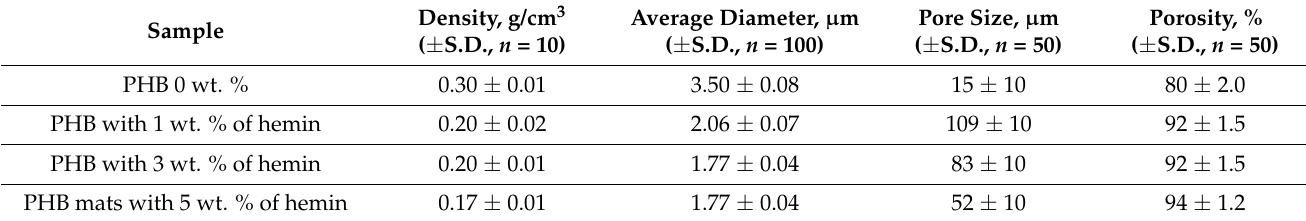
Table 1. Average values of the characteristics of the nonwoven materials based on PHB with different content of hemin. Density, g/cm 3 Sample ( ± S.D., n = 10) ( ± S.D., n = 50) PHB 0 wt. % PHB with 1 wt. % of hemin PHB with 3 wt. % of hemin PHB mats with 5 wt. % of hemin